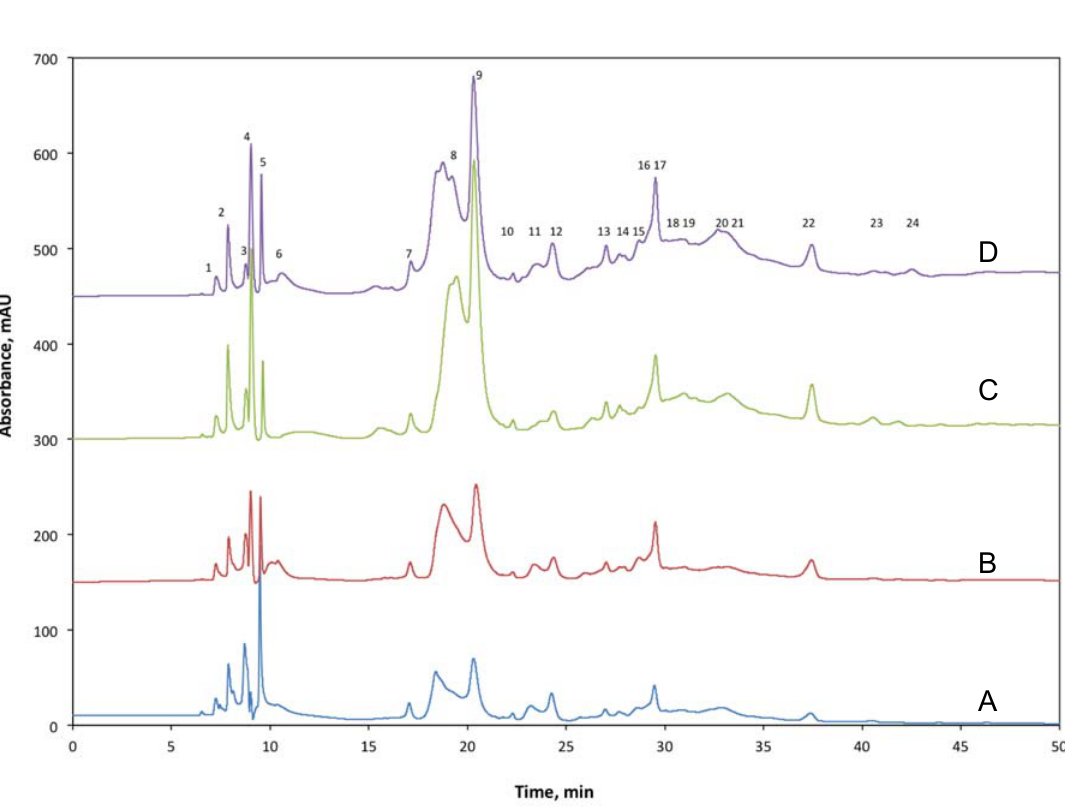
Table 1. Total area of peaks in the chromatograms corresponding to the extracts obtained using the different pretreatment procedures, at 280 nm for phenolic compounds and 520 nm for anthocyanins.